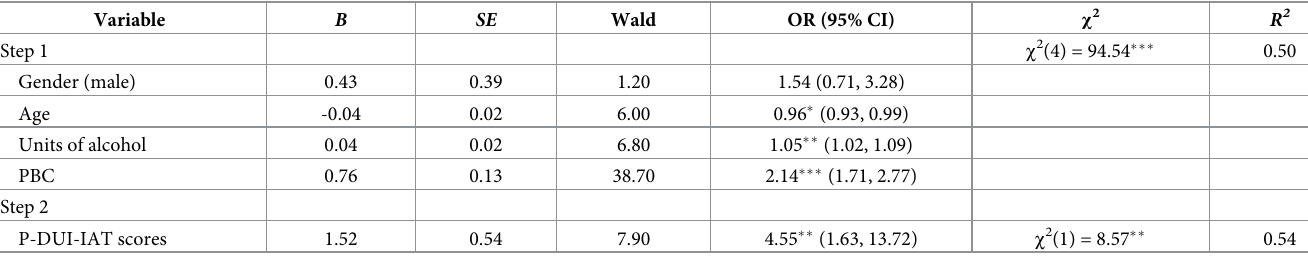
Table 7. Hierarchical logistic regression predicting past month drunk driving (Study